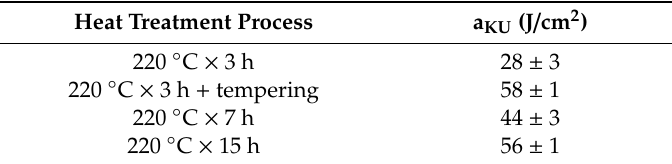
Table 3. The impact properties of the experimental steels underwent di ff erent heat treatment